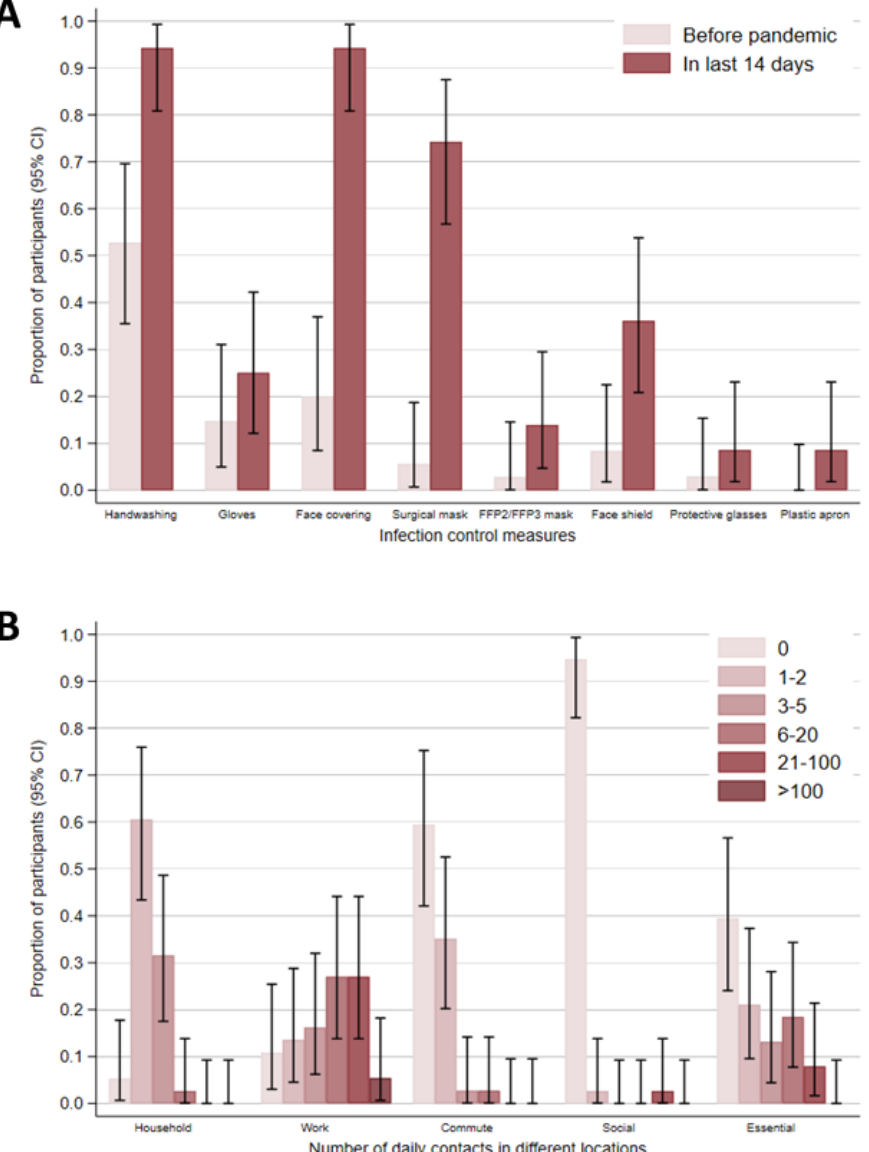
Figure 2. Baseline questionnaire responses of participants from an automotive manufacturing site—England, United Kingdom . ( A ) Proportion of participants reporting infection control mea- sures at workplace before the pandemic and within 14 days prior to completing the questionnaire. ( B ) Proportion of participants reporting their daily number of contacts in different locations within the last 14 days of completing the questionnaire. Error bars represent 95% confidence intervals (CI). The following data were missing: handwashing before pandemic ( n = 2) and in last 14 days ( n = 3), gloves before pandemic ( n = 4) and in last 14 days ( n = 2), face covering before pandemic ( n = 3) and in last 14 days ( n = 3), surgical mask before pandemic ( n = 2) and in last 14 days ( n = 3), FFP2/ FFP3 mask before pandemic ( n = 2) and in last 14 days ( n = 2), Face shield in pandemic ( n = 2) and in last 14 days ( n = 2), protective glasses before pandemic ( n = 4) and in last 14 days ( n = 3), plastic apron before pandemic ( n = 2) and in last 14 days ( n = 3), household contacts ( n = 0), work contacts ( n = 1), commute contacts ( n = 1), social contacts ( n = 0), and essential contacts ( n = 0). An environmental assessment was carried out at the manufacturing site, which occu- pied an 8400 m 2 building and housed 266 workers (235 permanent employees, 29 agency staff, and 2 contracted members of cleaning staff). The building was divided by walls into three main sections: warehousing ( n = 12 workers; 5.6 persons/1000 m 2 ), an